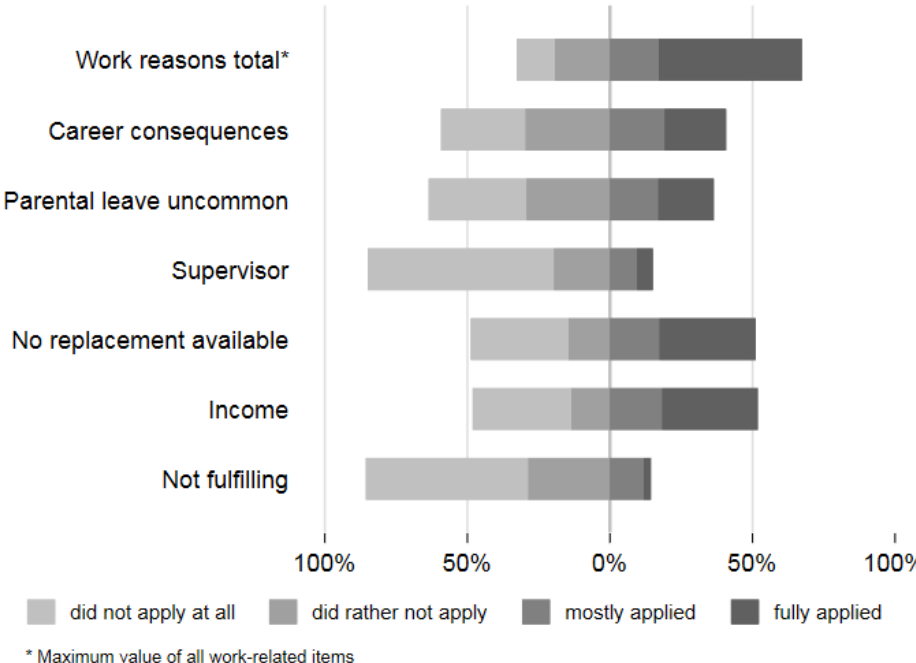
Figure 1. The fathers’ reasons for not taking parental leave. N = 367, weighted results.